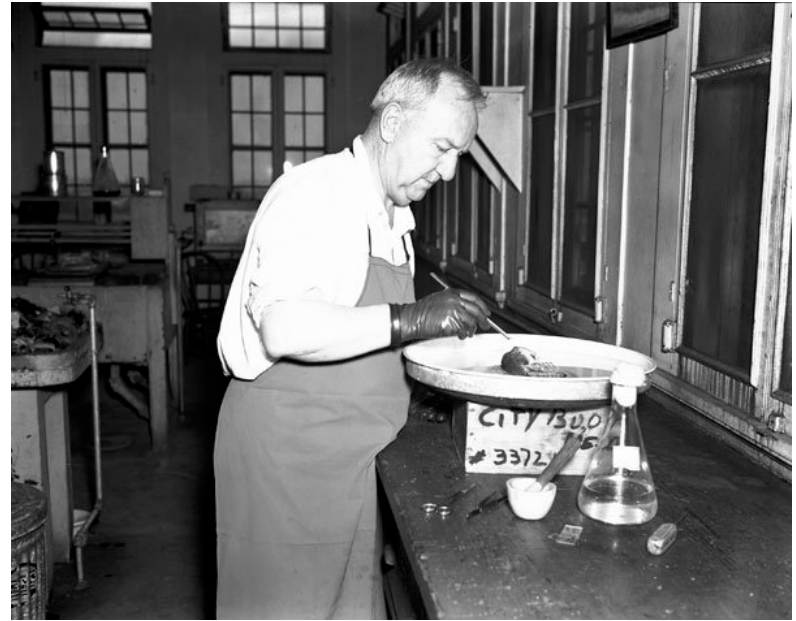
Figure 7. Works Progress Administration technician removing fleas from rat for quantification and identification, New Orleans, 1936. identification, New Orleans,